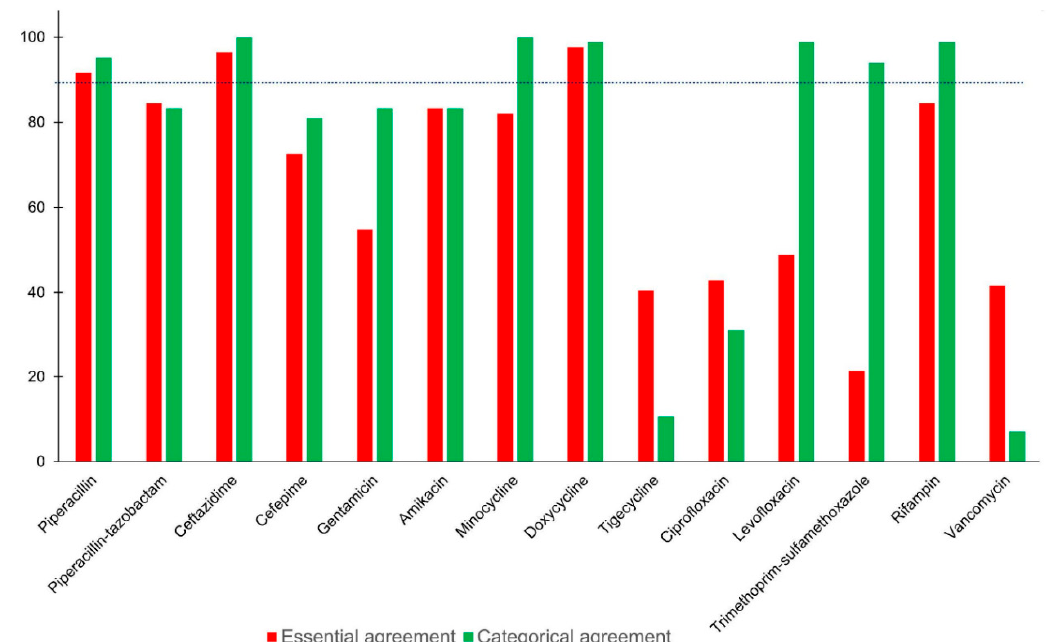
Figure 2. Essential agreement and categorical agreement between the Etest and agar dilution methods for the antimicrobial susceptibility testing of E. anophelis . The broken line indicates an agreement rate of 90%.